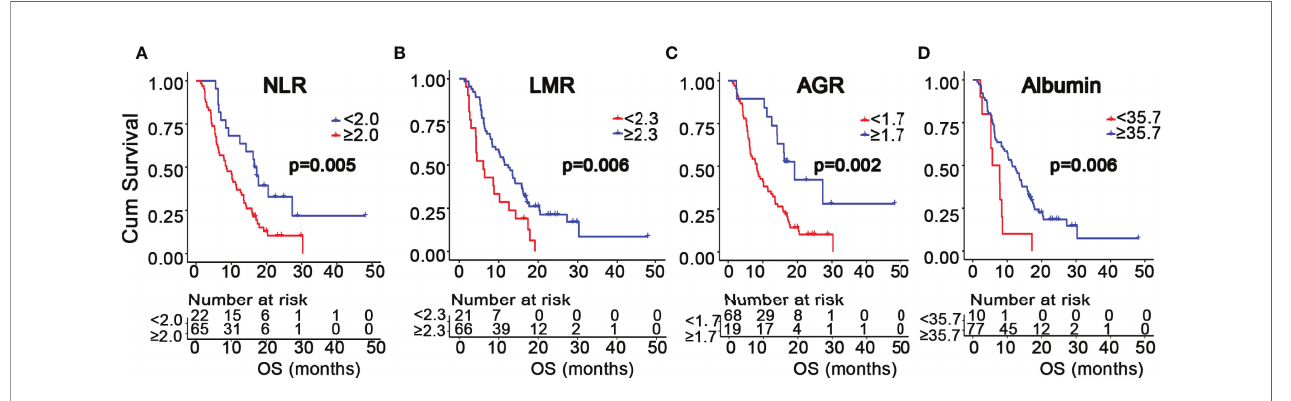
FIGURE 1 | Kaplan-Meier survival curves of GBM patients based on the cutoff values of NLR (A) , LMR (B) , AGR (C) , and albumin